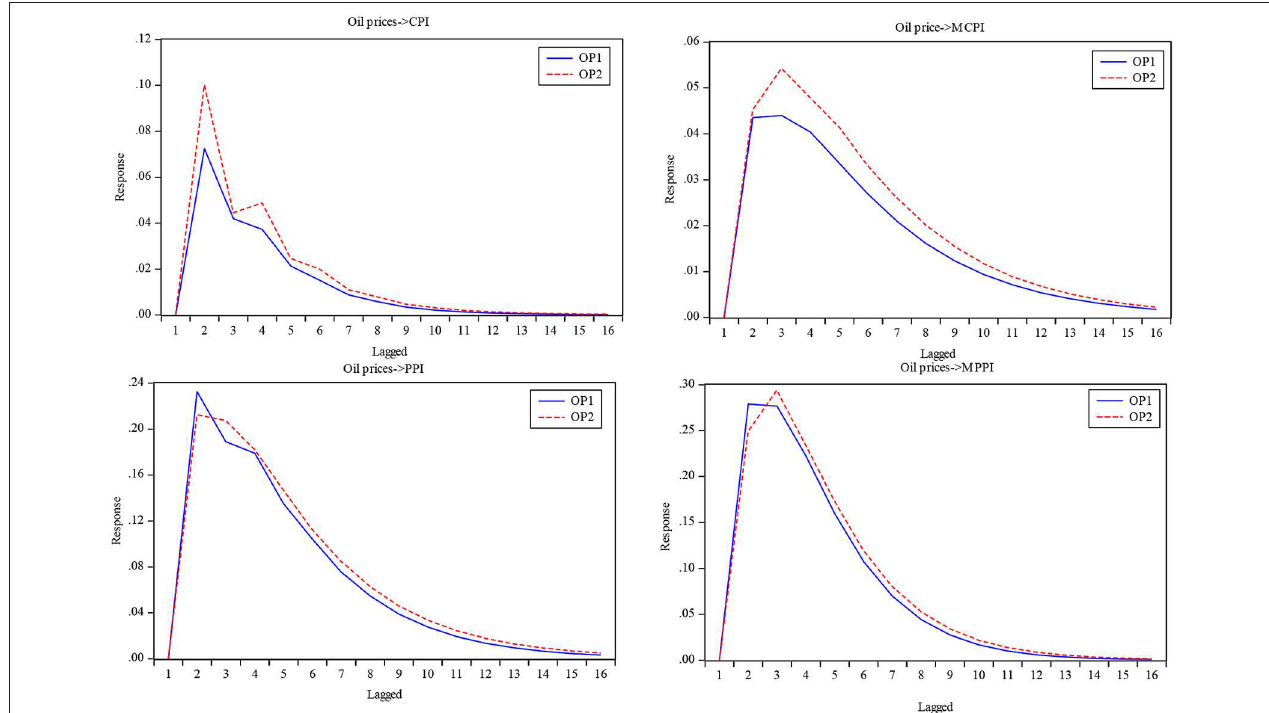
FIGURE 1 | The response of consumer/producer prices to oil prices without a monetary policy. OP1 and OP2 stand for Brent oil price and WTI oil price, respectively.